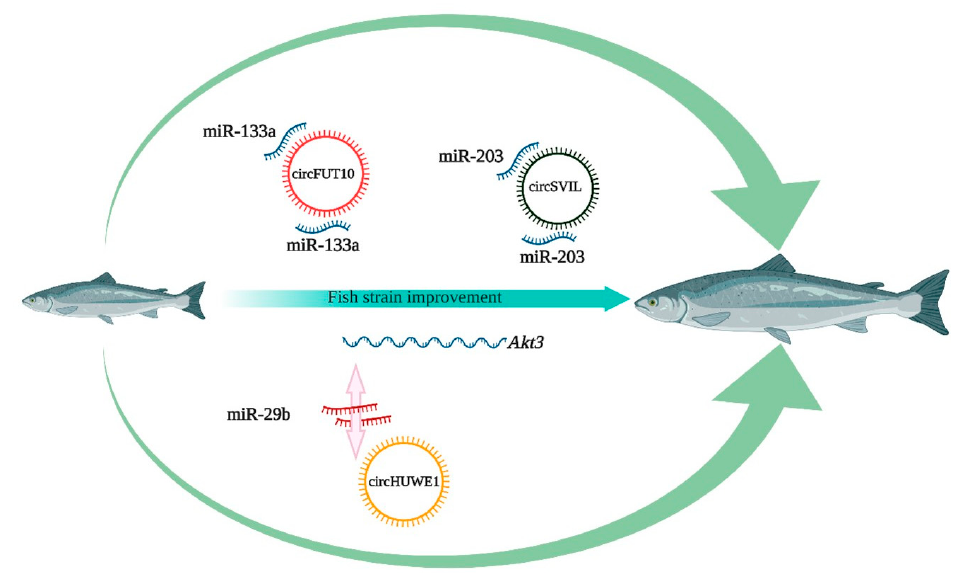
Figure 4. Proposed application of circRNAs in improved fish growth using their miRNA sponge and ceRNA properties.